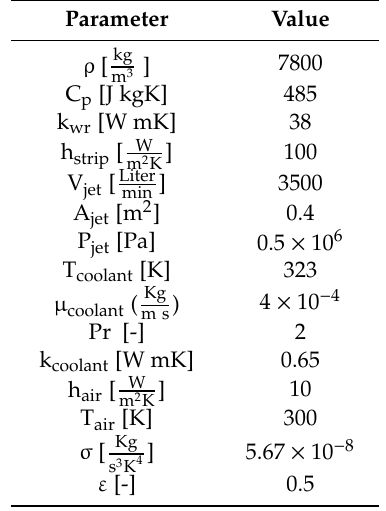
Table 1. Process parameter